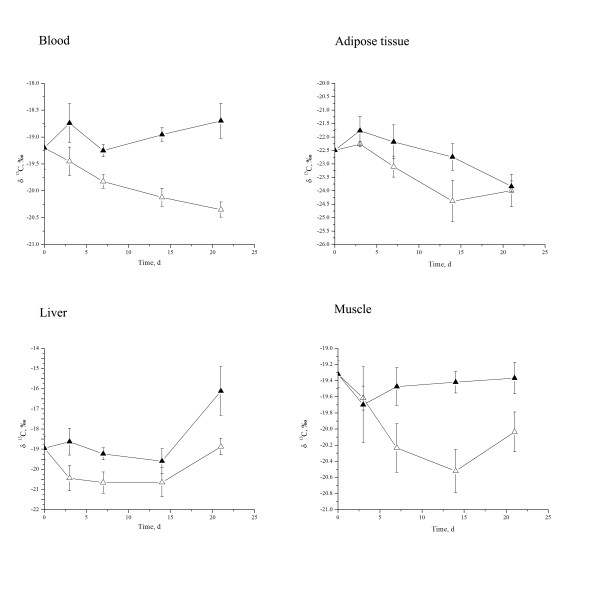
δ13C value change in Sprague–Dawley rat blood, adipose tissue, liver, and muscle over time. Open triangles are treatment δ13C = −21.76‰, δ15N = 0.53‰ and filled triangles are treatment δ13C = −19.34‰, δ15N = 4.73‰. Data are expressed as mean ± SE.